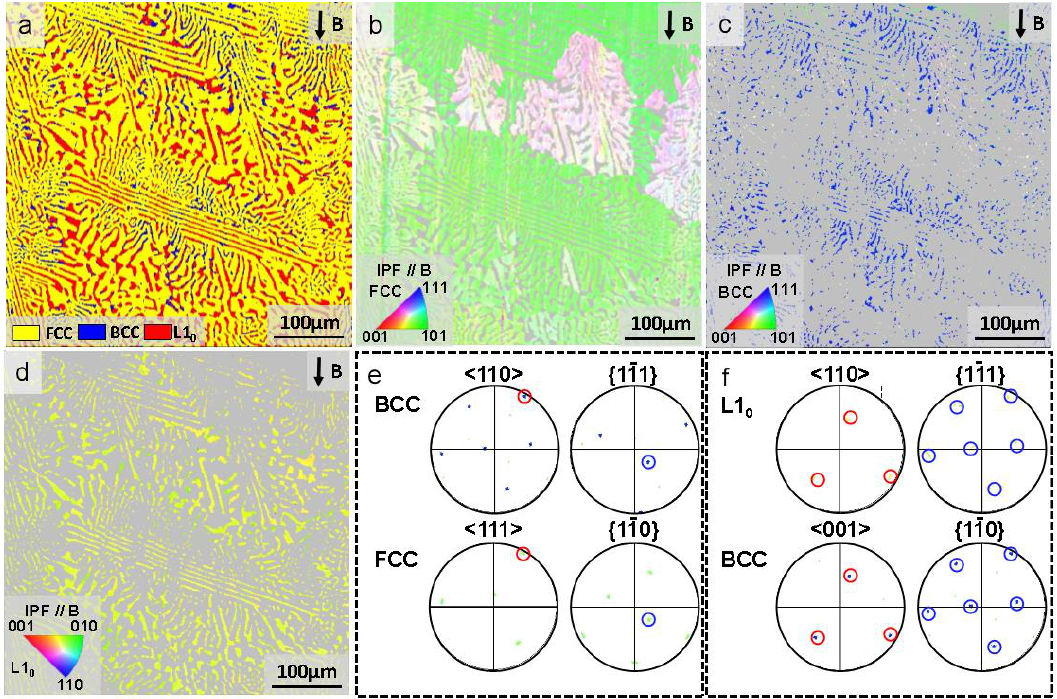
Figure 10. EBSD results for the 5 T sample. ( a ) Phase map; ( b ) IPF map of FCC phases; ( c ) IPF map of BCC phases; ( d ) IPF map of L1 0 phases; ( e ) pole figures of FCC and BCC phases in single eutectic colony. The pole points on the (1-11) (blue circle) and [110] (red circle) pole figures of the BCC phase overlap with those on the (1-10) (blue circle) and [111] (red circle) pole figures of the FCC phase; ( f ) pole figures of L1 0 martensite and BCC austenite. The pole points on the (1-11) (blue circle) and [110] (red circle) pole figures of the L1 0 phase overlap with those on the (1-10) (blue circle) and [001] (red circle) pole figures of the BCC austenite phase, implying the preferred orientation relationship.